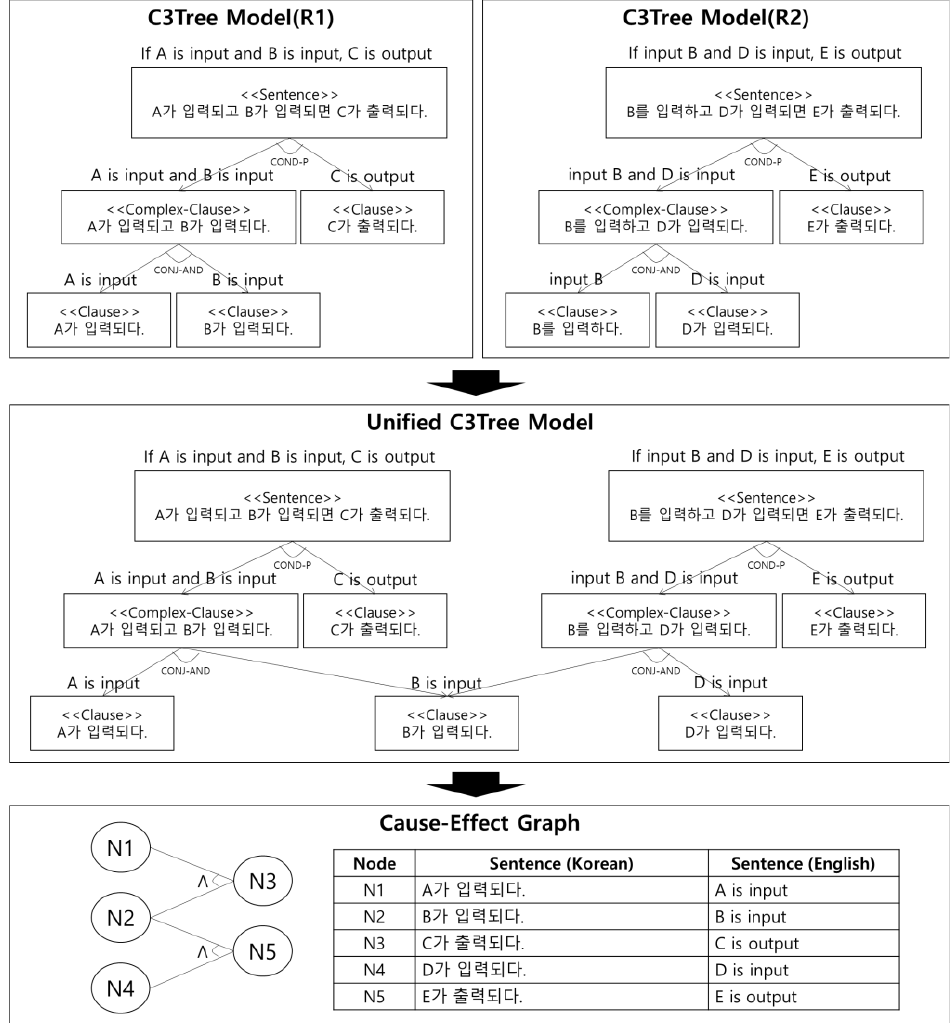
Figure 11. Cause – effect graph generation from C3Tree model of two requirement sentences R1 and Figure 11. Cause–effect graph generation from C3Tree model of two requirement sentences R1 R2. and